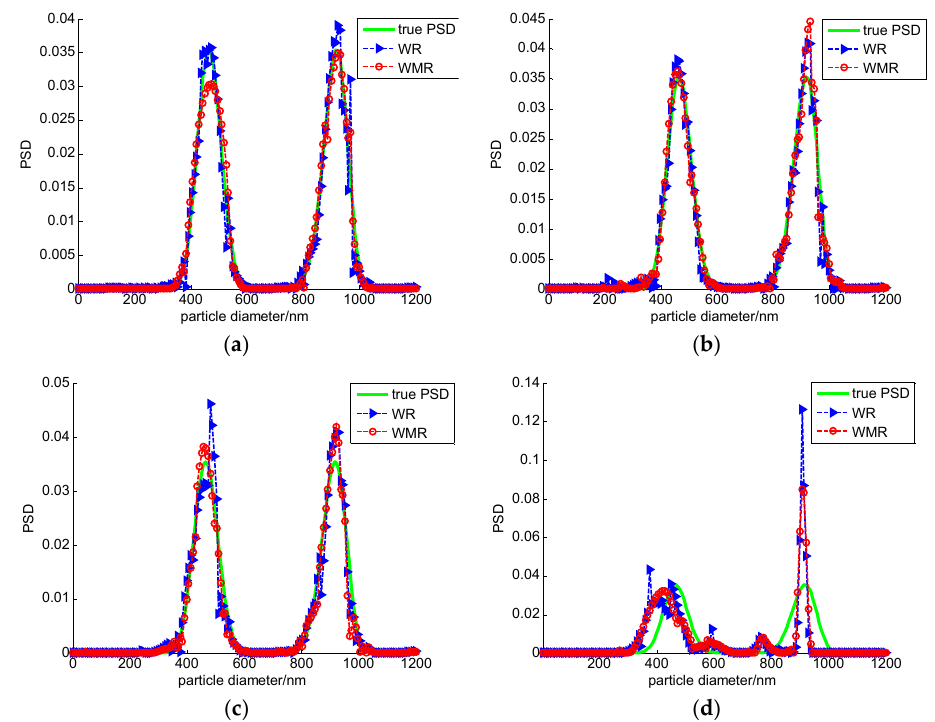
Figure 1. The inversion results with WR and WMR from 466/915 nm bimodal simulated DLS data under different noise levels: ( a ) noise level is 0; ( b ) noise level is 10 − 4 ; ( c ) noise level is 10 − 2 ; ( d ) noise level is 0.08.